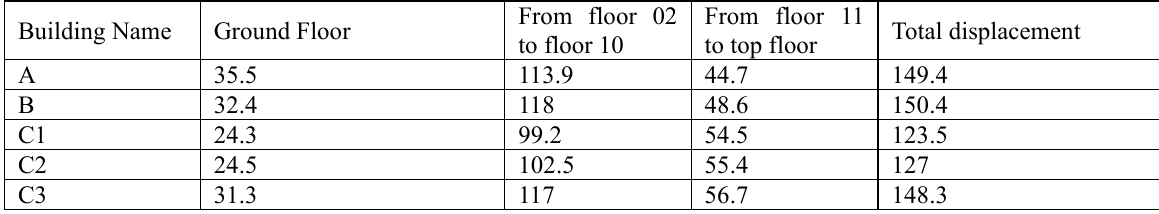
Floor wise displacement of